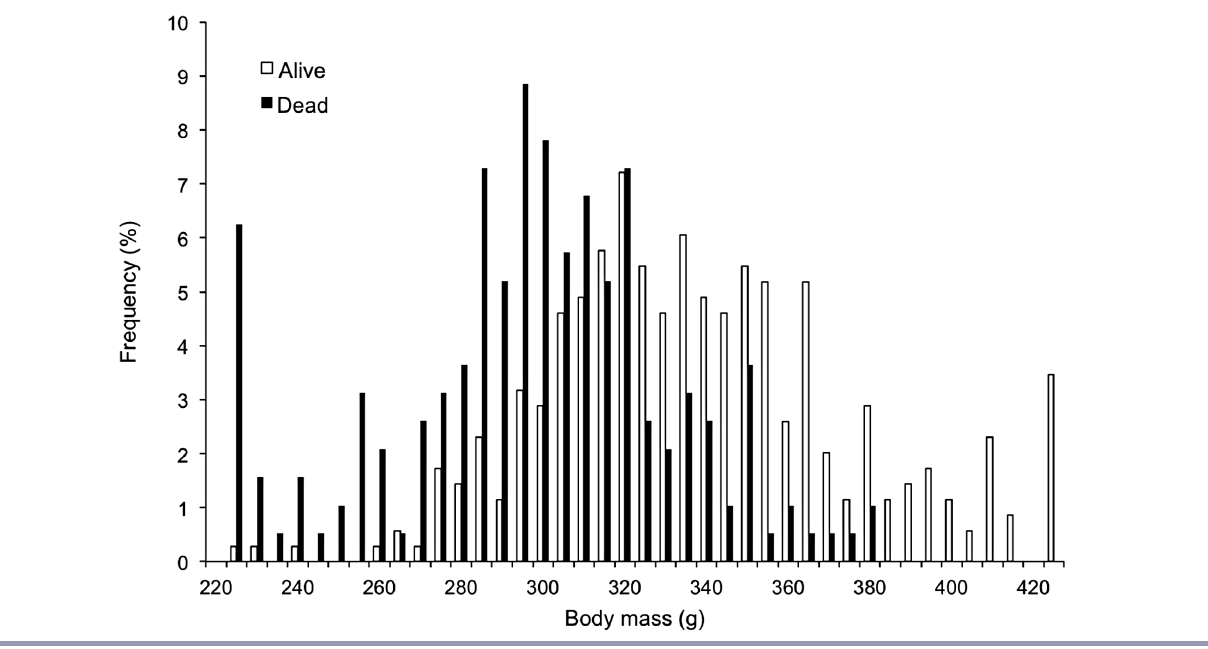
Fig. 7 . The body mass of road victims compared with live Barn Owls ( Tyto alba ). Although the overlap is considerable, road victims had on average a lower body mass (Wilcoxon; m [dead owls] = 192, n [live owls] = 347, R = 32247, p < 0.001). s